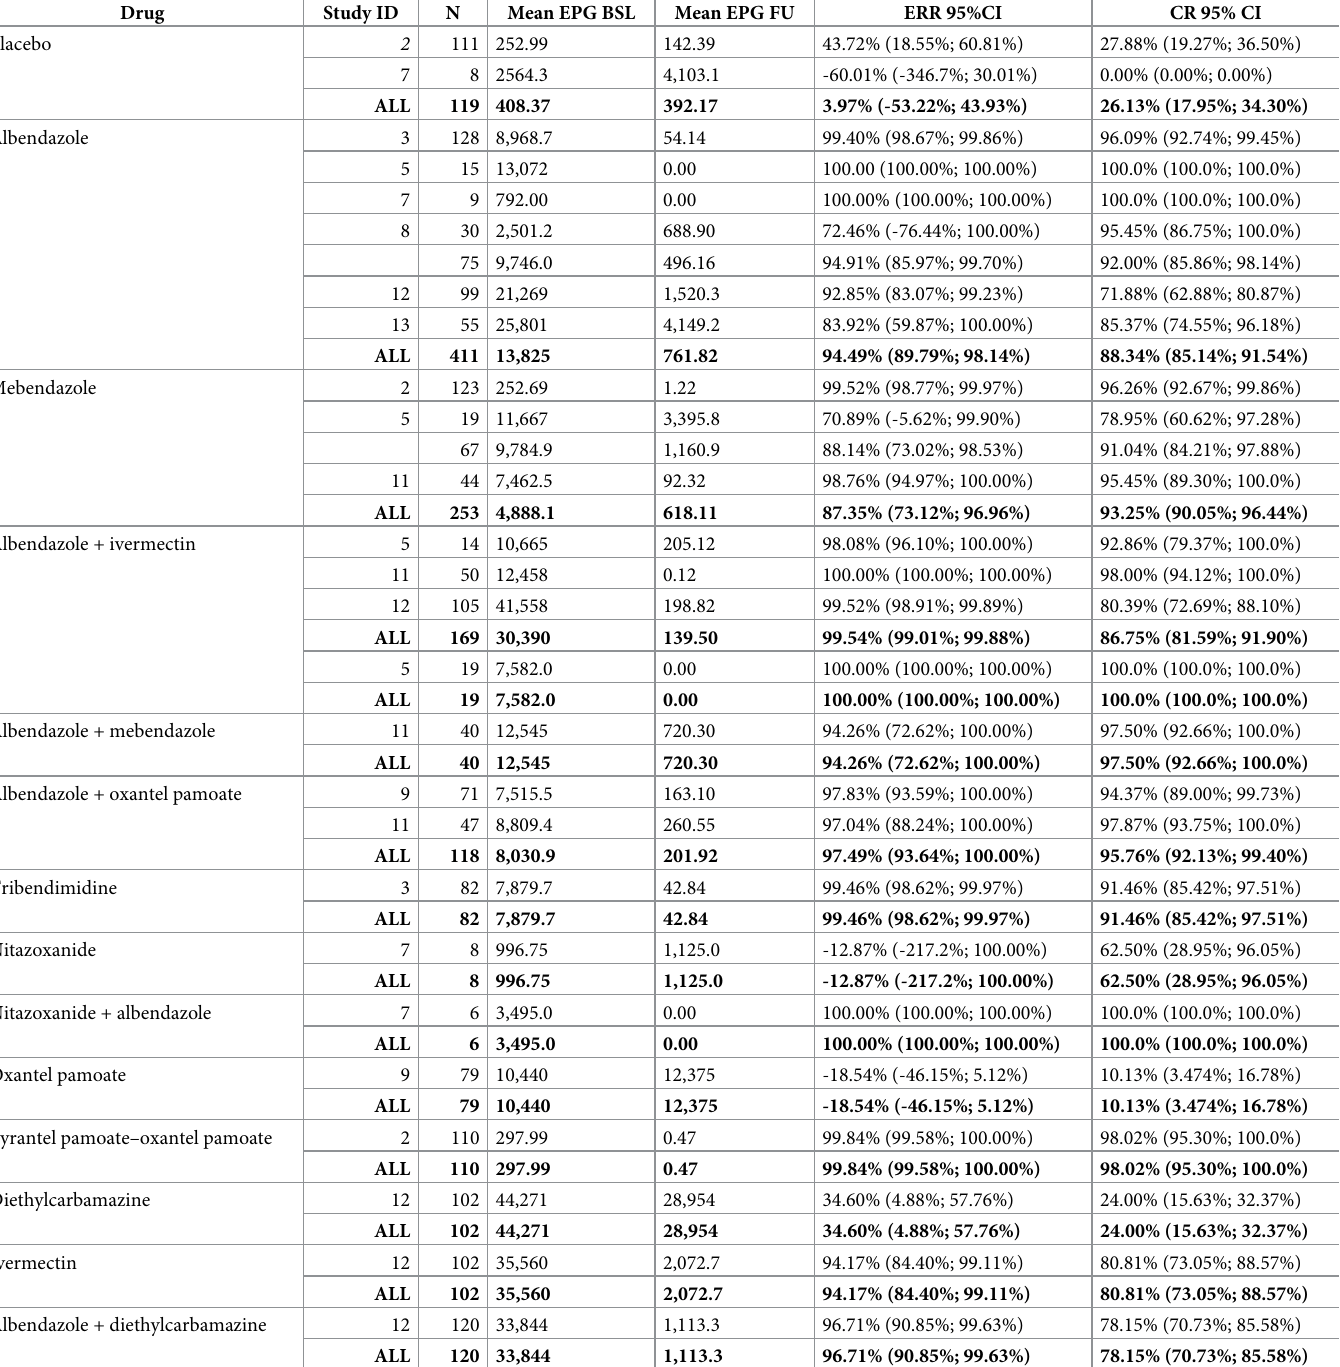
Table 4. Egg count arithmetic means before and after treatment and drug efficacy outcomes (group egg reduction rate, ERR) for studies with follow-up duration between 14 and 21 days for Ascaris lumbricoides .